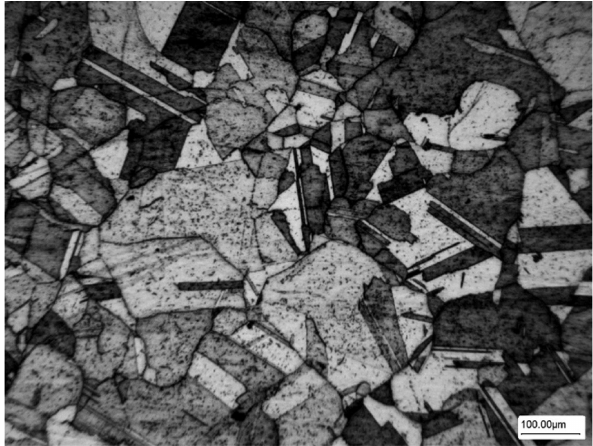
Figure 6: Microstructure of GH80A.